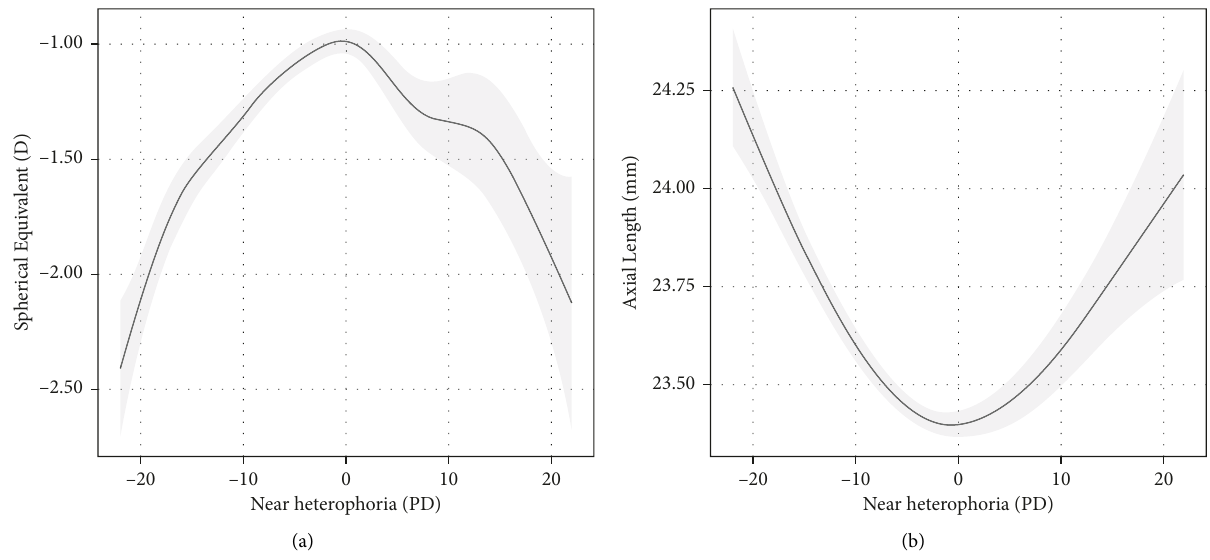
Figure 3: (a) Nonlinear relationship between near heterophoria and SE. The gray area represents the 95% confidence interval of the estimated SE. (b) Nonlinear relationship between near heterophoria and AL. The gray area represents the 95% confidence interval of the estimated AL.